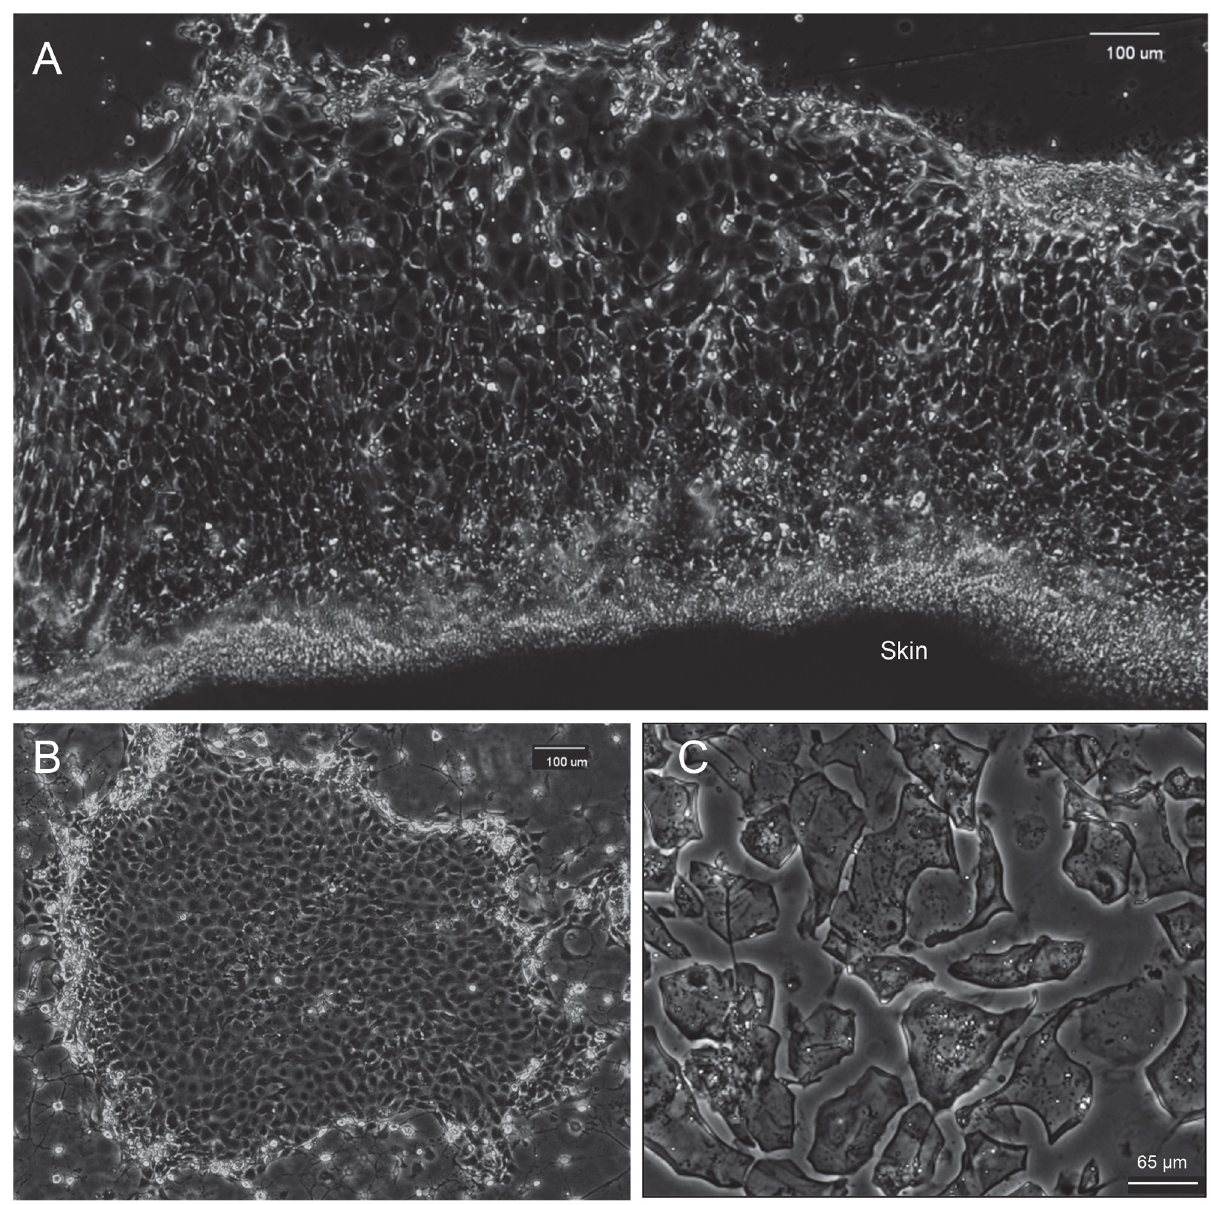
Fig 1. Cultures of sturgeon epidermal cells. (A) Sheet of epithelial cells expanding outward from explant of white sturgeon skin (at bottom of panel). (B) Colony of green sturgeon epidermal cells in primary culture surrounded by sparse 3T3 feeder layer cells. (C) Squame-like cells remaining attached to dish after treatment of confluent culture of white sturgeon cells with ionophore X537A overnight followed by SDS + DTT. epidermal cells [37]. By contrast, the fraction of adherent cells capable of envelope formation upon ionophore treatment was 60% ± 5%, comparable to the degree of envelope formation in cultured human epidermal keratinocytes [38]. To obtain this value, untreated cultures were trypsinized and counted to give total cell numbers, while parallel cultures (without trypsiniza- tion) were incubated overnight with ionophore and counted following treatment with SDS and DTT. In such experiments, envelope formation is prevented by treatment of human cells